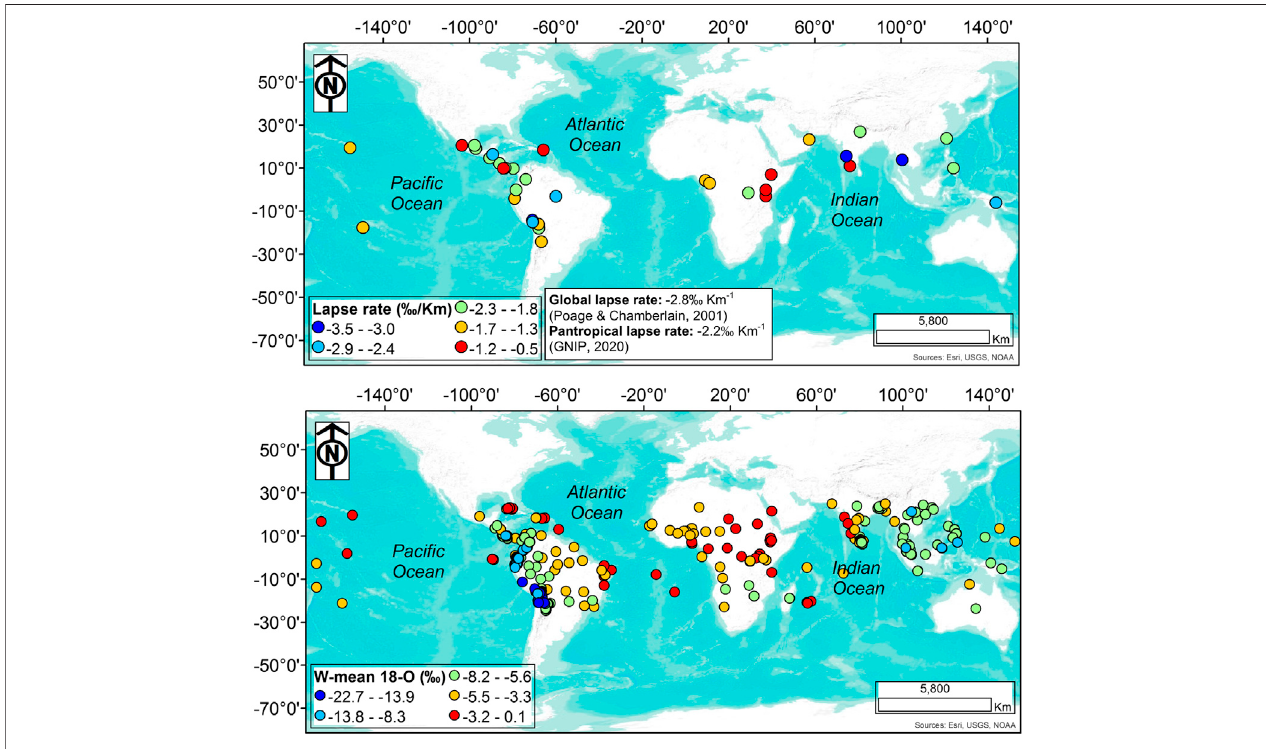
FIGURE 1 | Isotopic variations across the tropics. The upper panel shows isotopic lapse rates across the tropics based on published data (see Supplementary TableS1 fordetails).Thelowerpanelincludesweighted δ 18 Omeansacrossthetropicsbasedon349stations(N (cid:2) 18,659monthlysamples)fromtheGlobalNetworkof Isotopes in Precipitation (GNIP). Figure adapted using data from IAEA/WMO (2020) and Munskgaard et al. (2019).